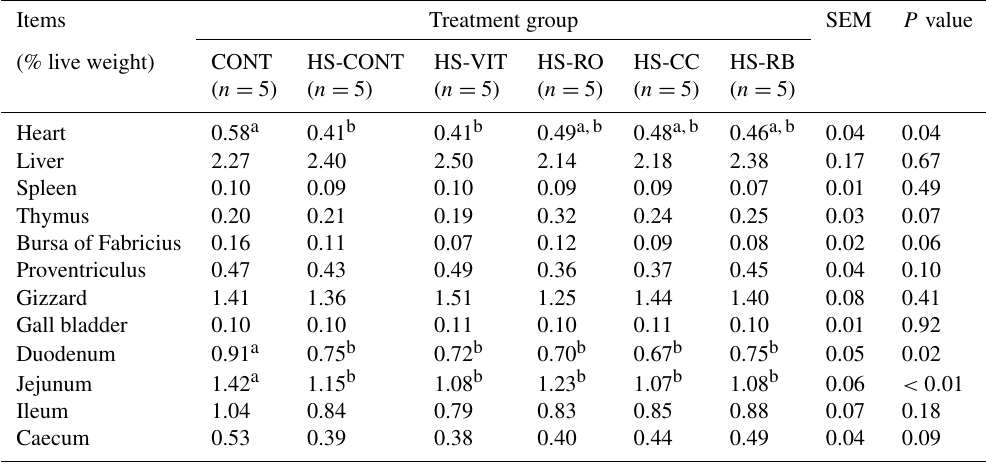
Table 4. Effect of dietary supplementation on internal organs of broilers reared under normal or HS conditions. Items Treatment